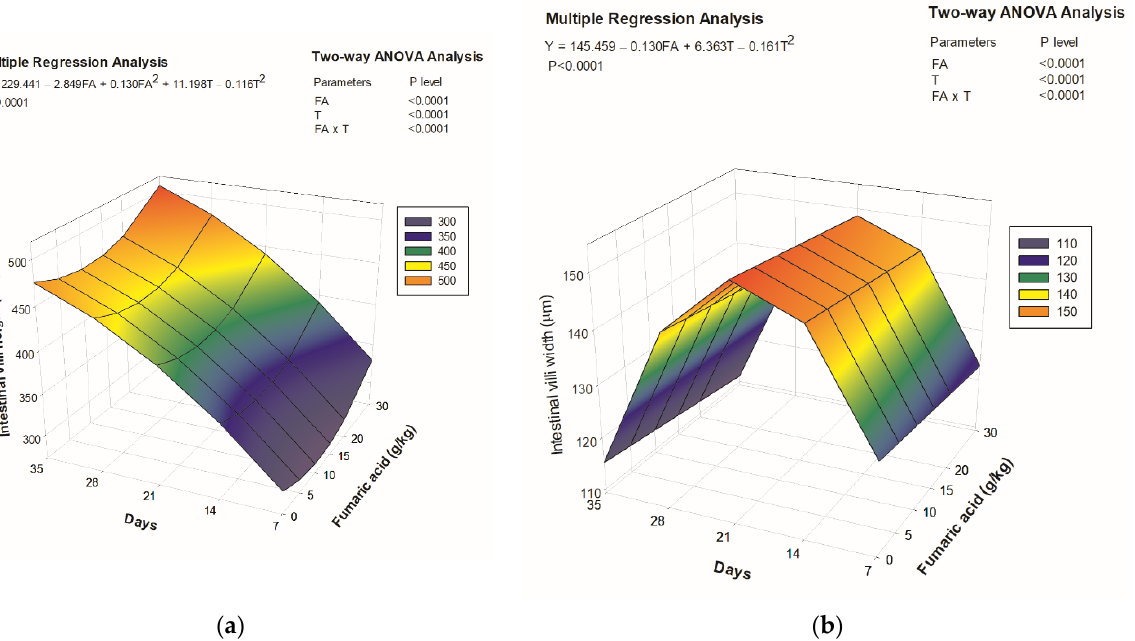
( b ) Figure 2. Relationship between bacteria counts in the gut of Nile tilapia juveniles and dietary fu- maric acid levels through 35 days: ( a ) Gram negative bacteria; ( b ) Enterobacteriaceae. FA: fumaric